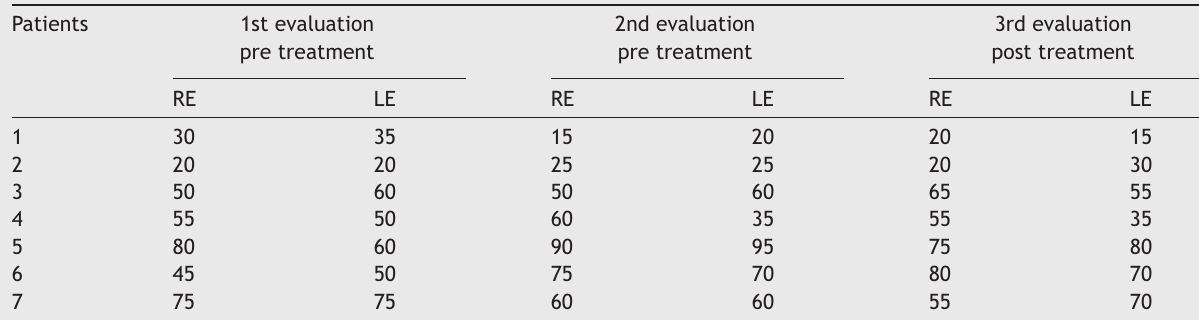
Results of STR (dB).